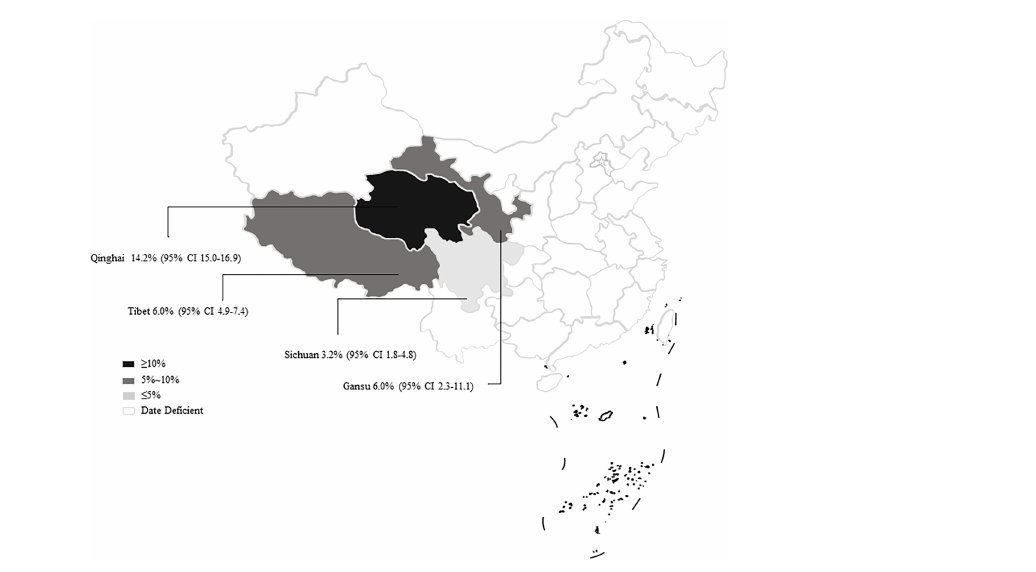
FIGURE 7 | Map of Cryptosporidium prevalence in yaks in